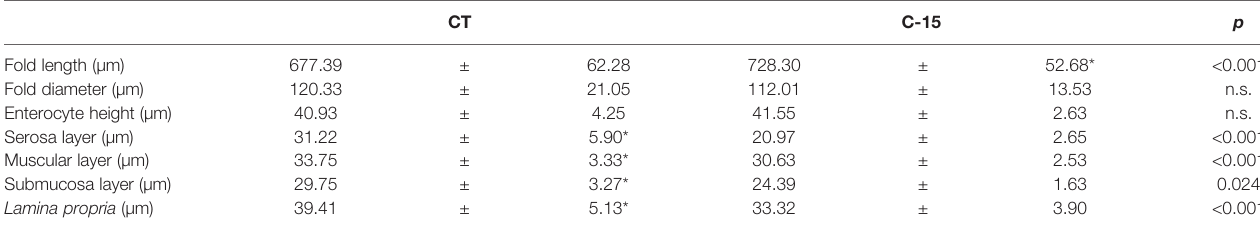
TABLE 7 | Quanti fi cation of the histological parameters assessed in the intestine of juvenile C. labrosus fed control (CT) and C-15 diets during 90 days. CT C-15 p Fold length